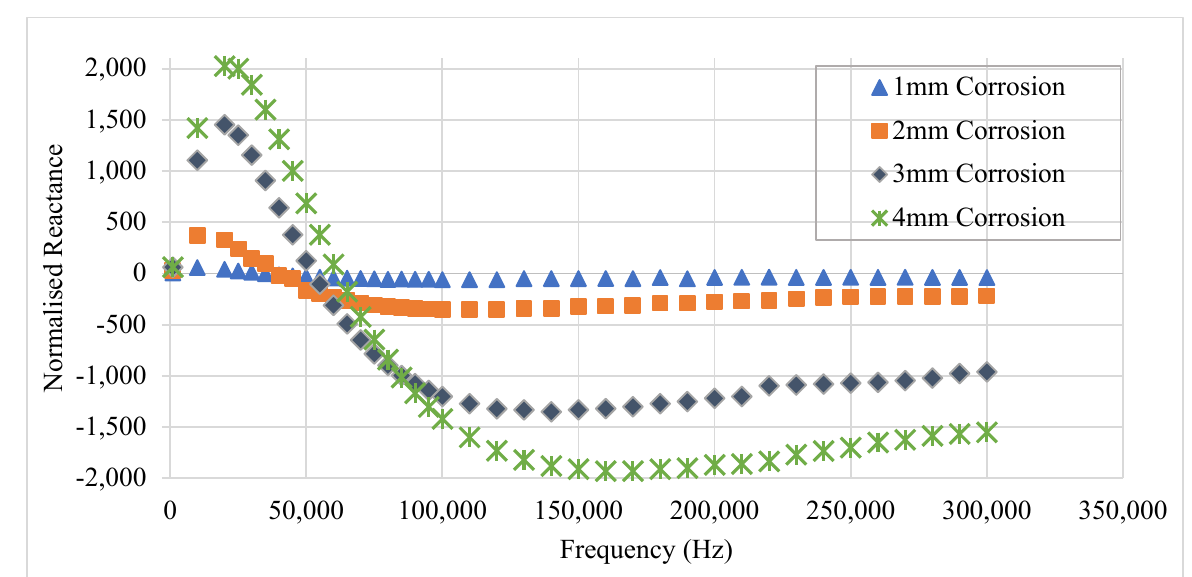
Figure 7. The normalized reactance values for steel plates at different excitation frequencies.